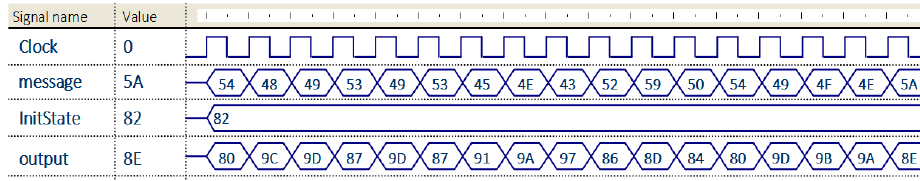
Figure 11. ( a ) Entire cryptosystem; ( b ) FPGA board. The hybrid cellular automata with the best statistical properties were analyzed, im- plemented, tested and evaluated in software and hardware (FPGA). Due to their proper- ties, cellular automata are suitable for hardware implementation, and by using some in- struction parallelization algorithms [29], increased speeds can be obtained for securing data transmitted in heterogeneous telecommunication networks. 4. Testing and Results This section focuses on testing the quality of the proposed encryption algorithm. Sta- tistical tests, along with graphical representations, were performed to assess the random- ness of the produced results, ending with a discussion about the cryptosystem and appli- cations developed in this work. For analyzing cryptographic algorithm results, we used a series of statistical tests provided by the National Institute of Standards and Technology (NIST) to check whether the produced sequence complies with the requirements of a pseudorandom number gen- erator [30]. The NIST Test Suite is a collection of 15 statistical tests designed to assess the randomness of binary sequences generated by cryptographic random or pseudorandom number generators, regardless of whether they are hardware- or software-based. These tests are designed to detect various forms of non-randomness that may be present in a sequence. To evaluate the randomness of a sequence, a range of statistical tests can be em- ployed. These tests are designed to identify non-randomness in the sequence and produce a test statistic value as a function of the data. Based on the test statistic value, a p -value is calculated, which represents the probability that a perfect random number generator would produce a less random sequence than the one tested. A significance level (α) is